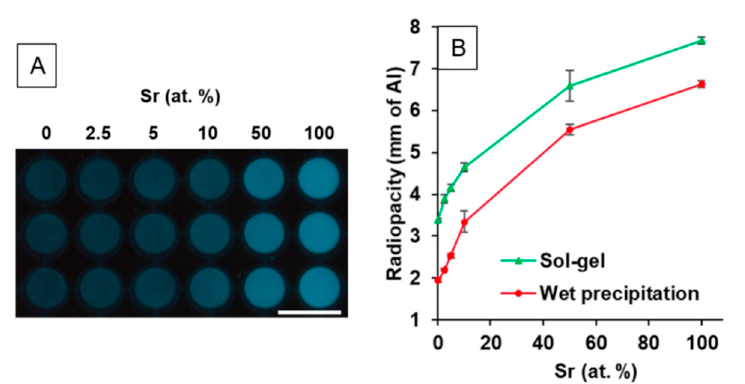
Figure 6. ( A ) Radiograph of SrHA powders (0, 2.5, 5, 10, 50 and 100 at.% Sr) produced using the